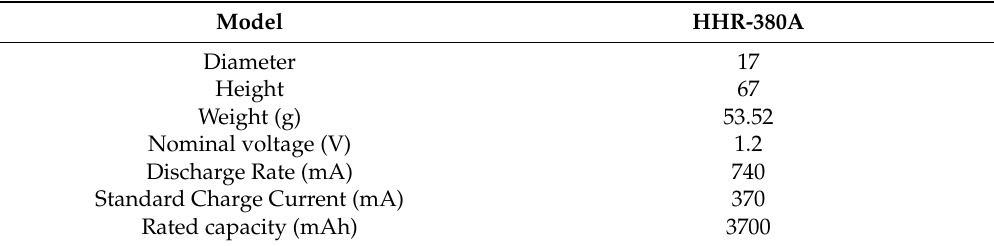
Table 2. Primary Specifications of Ni-MH Panasonic-BSG cell.